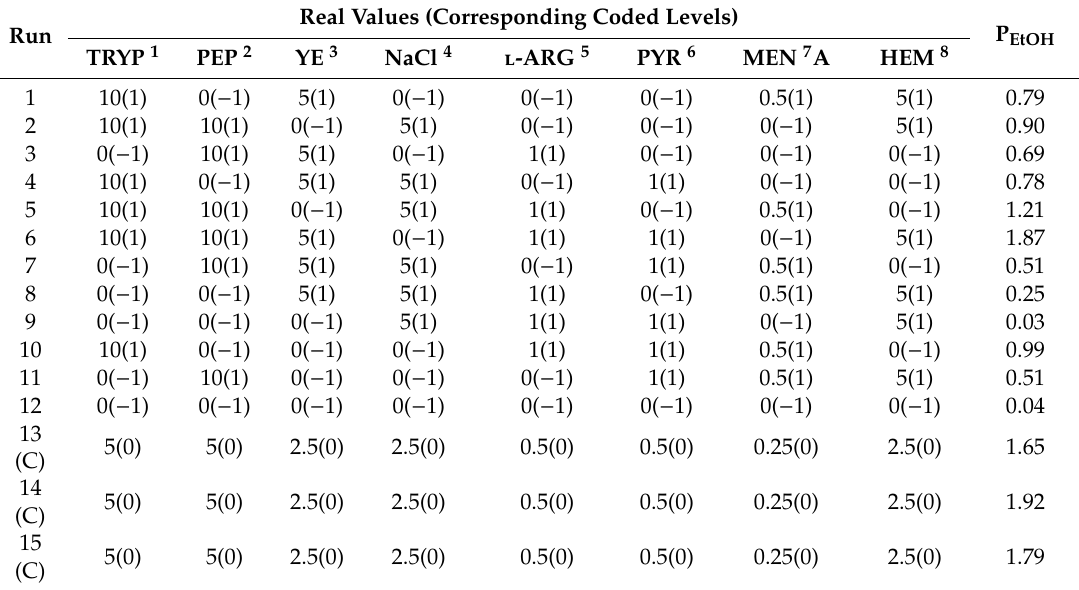
Table 1. Placket–Burman design matrix with real and coded values for C. carboxidivorans syngas fermentation with 1 g / L glucose. Response variables: ethanol production—P EtOH (g / L).